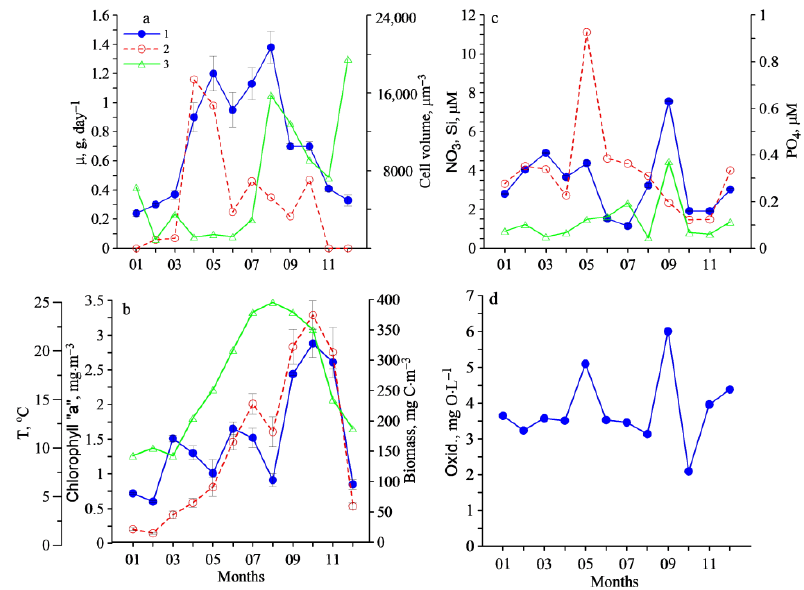
Figure 4. Seasonal variability: ( a ) phytoplankton growth rate (1), microzooplankton grazing (2) and average phytoplankton cell volume (3); ( b )chlorophyll a concentration (1), phytoplankton biomass (2), water temperature (3); ( c )nitrate (1), silicate (2), phosphate (3); ( d )the permanganate oxidizability (1) in Station 3.